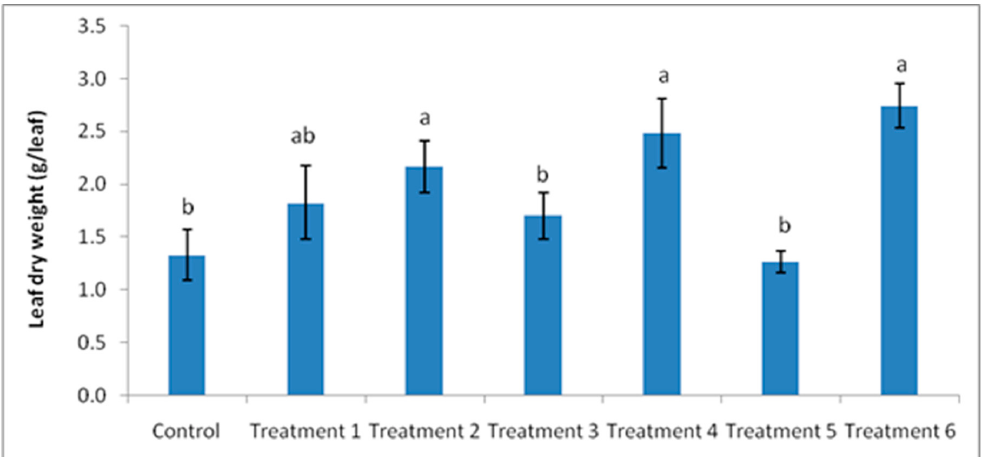
Figure 2. Effect of biochar, fertilizer, and manure on leaf biomass of cucumber. Different letters above the Figure 2. E ff ect of biochar, fertilizer, and manure on leaf biomass of cucumber. Di ff erent letters above bars suggested that these values are significantly different at p ≤ 0.05. the bars suggested that these values are significantly di ff erent at p ≤